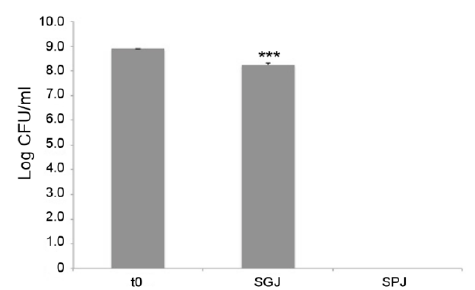
Figure 8. In vitro tolerance to simulated gastro-intestinal conditions. Cell counts of viable L. fermentum MBC2 recovered at the initial time point (t0), following 1h incubation in Simulated Gastric Juice (SGJ) and at the end of 2h incubation in Simulated Pancreatic Juice (SPJ). Data are reported as log of bacterial CFU recovered after plating. Columns represent the mean ± SD of two independent experiments, each performed in triplicate. Statistical analysis was performed by one-way ANOVA, followed by post- hoc Tukey honestly significant difference (HSD) test. Asterisks indicate significant differences (*** p < 0.001).